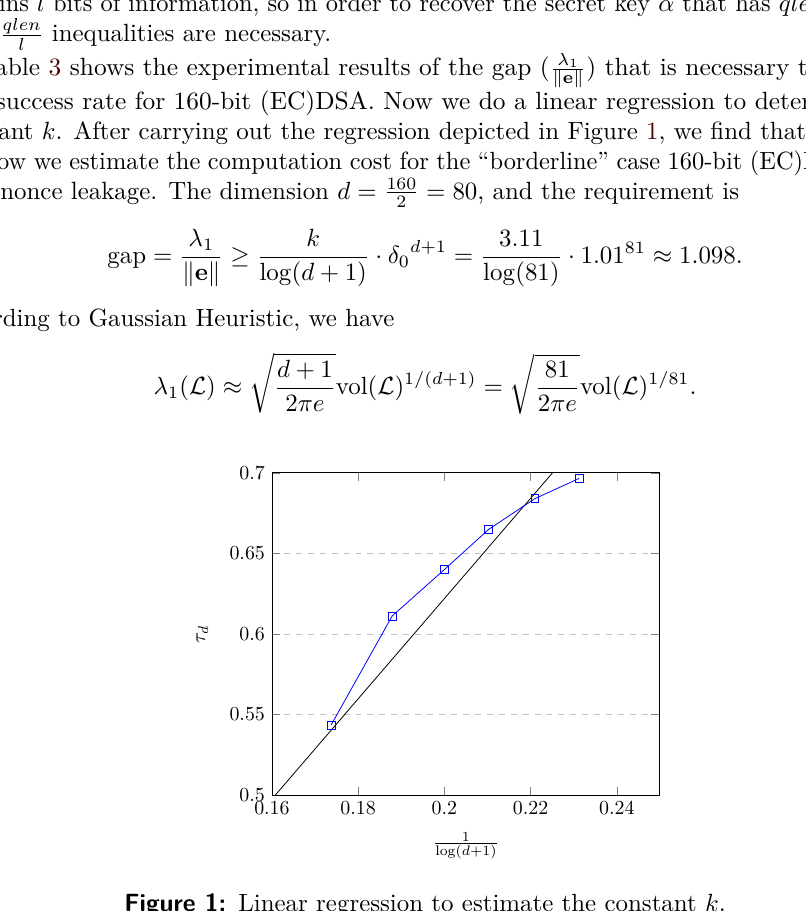
Figure 1: Linear regression to estimate the constant k